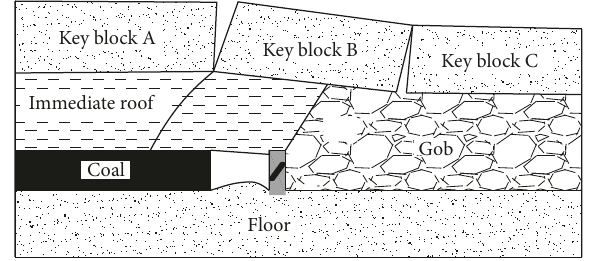
Figure 6: Diagram of the surrounding rock structure of gob-side entry retaining.